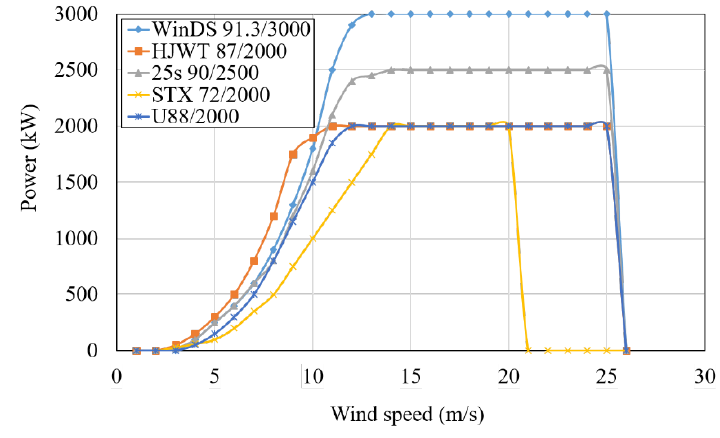
Figure 10. Power curves of selected wind turbines